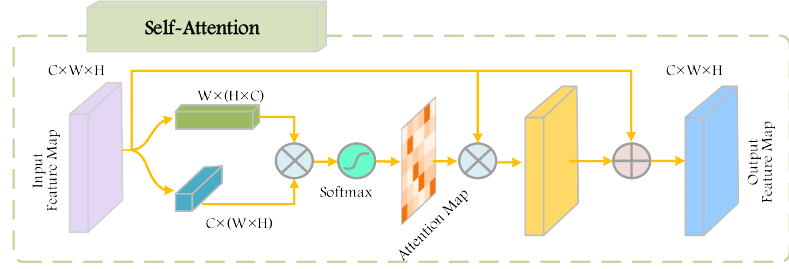
Figure 3. The diagram of the attention